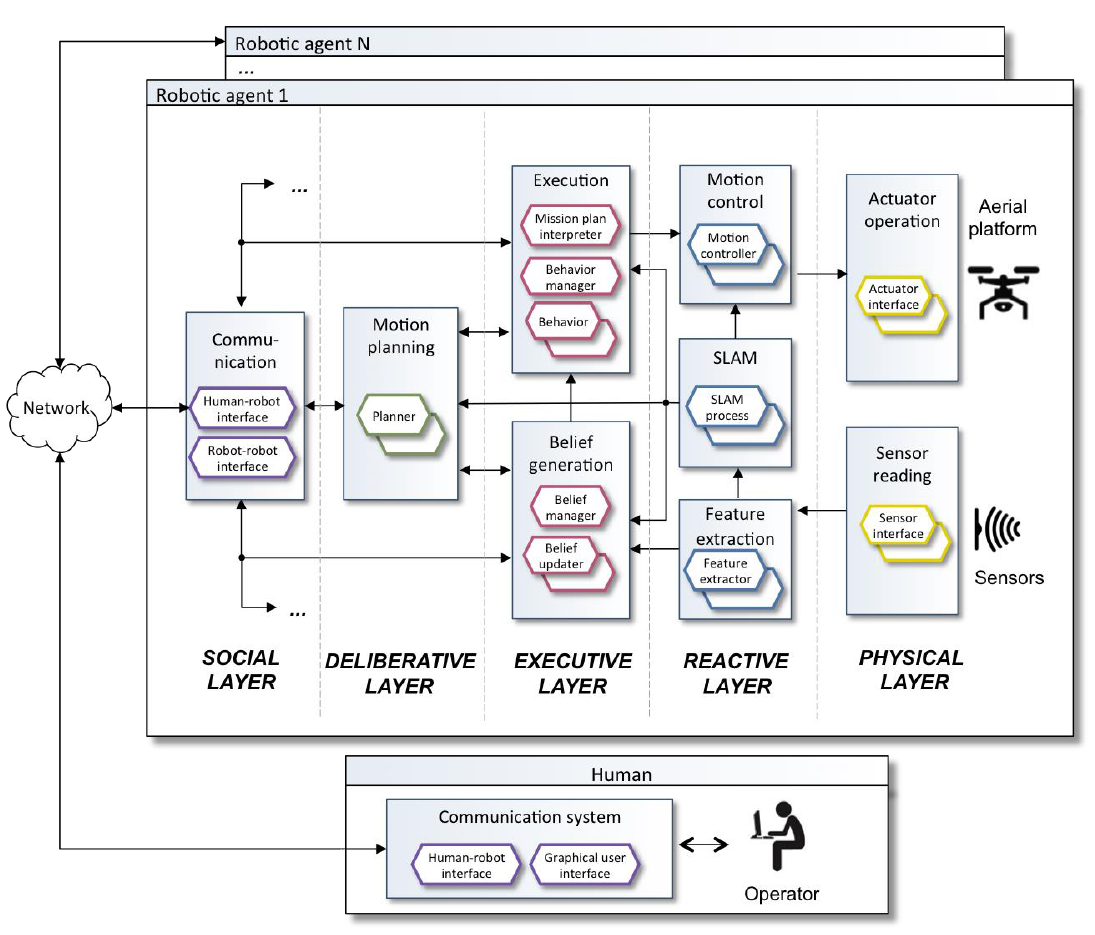
Figure 7. The multi-layered architecture of Aerostack.